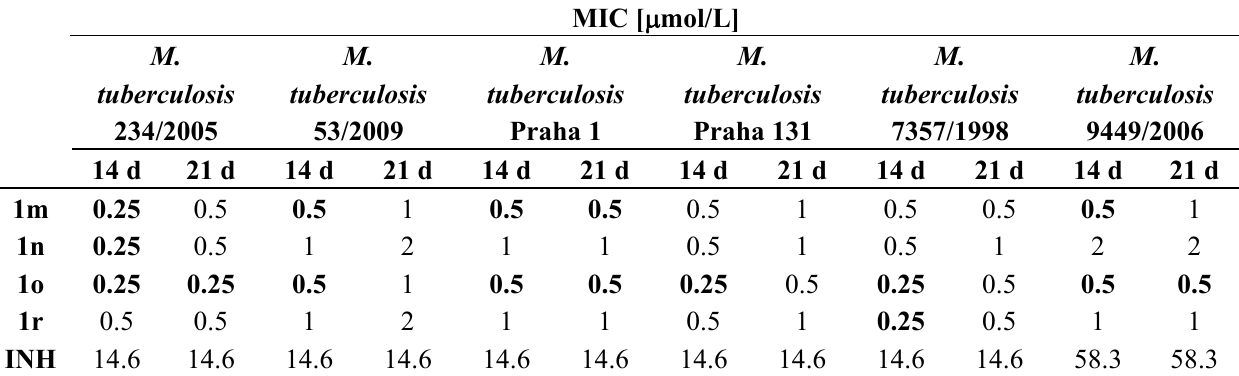
Table 3. Activity of selected benzoates against multidrug-resistant strains.